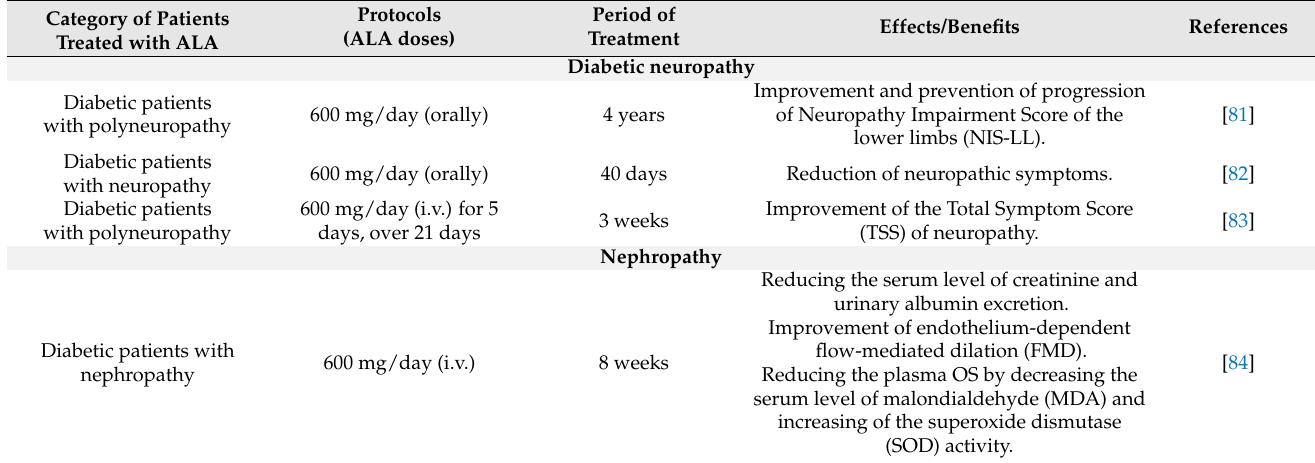
Table 1. A brief selection of the main effects or benefits of alpha-lipoic acid in various pathologies. Protocols Category of Patients (ALA doses) Treated with ALA